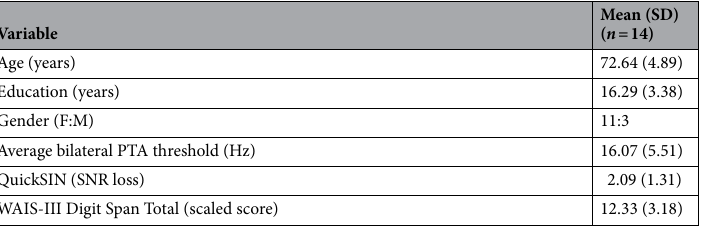
Table 1. Demographic, clinical, and hearing assessment data. Digit span scaled scores displayed were acquired from participants’ first visit pre-stimulation. PTA pure tone audiogram, SNR signal-to-noise ratio, WAIS-III Wechsler Adult Intelligence Scale, Third